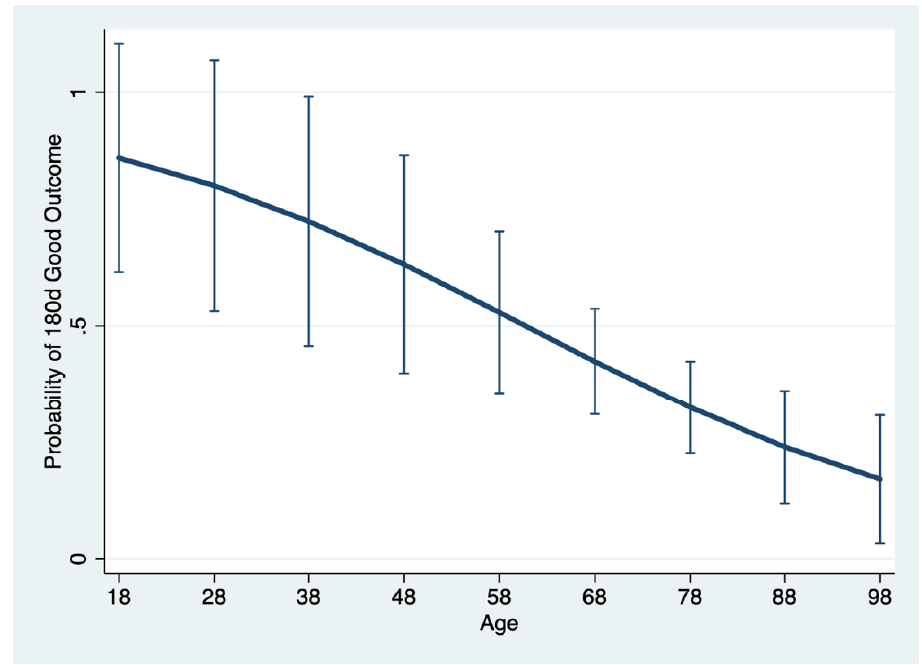
Figure 4. Marginal effect of age on the probability of a good outcome at 180 days; the other covariates of the multivariable model are kept fixed. A good outcome is defined as eventual return to home or discharge to assisted living (mRS < 2).